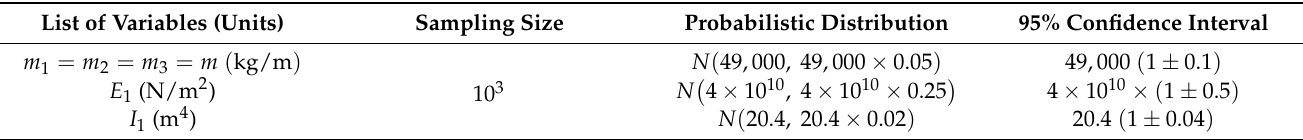
Table 2. Statistical definition of input variables.